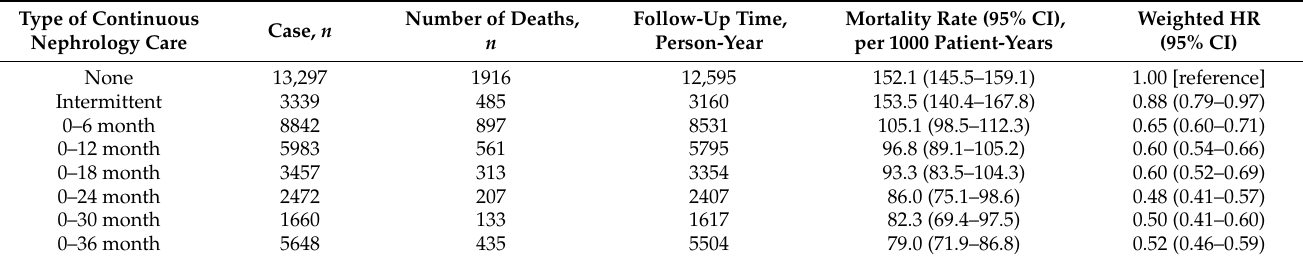
Table 4. Effects of cumulative continuous nephrology care on one-year mortality after